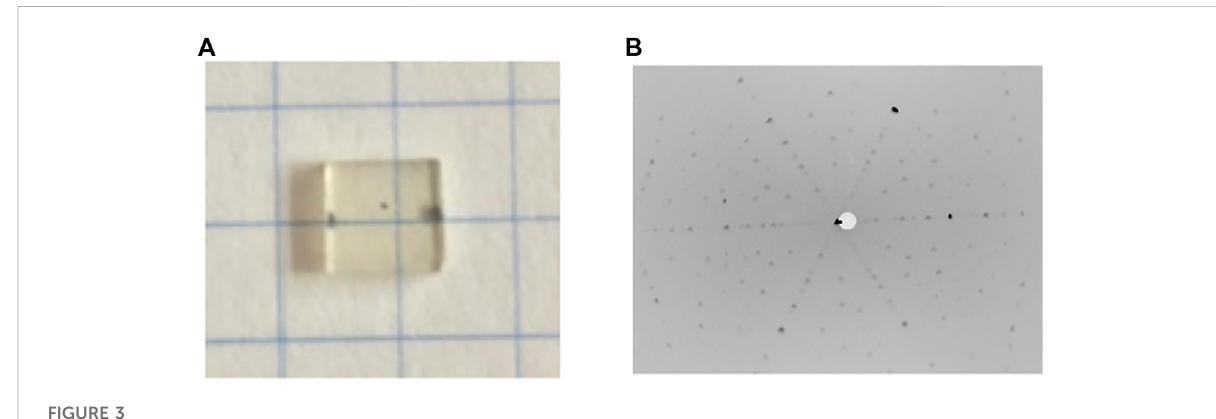
FIGURE 3 CTGS crystal (A) and back re fl ection Laue image on the crystal facet (B)